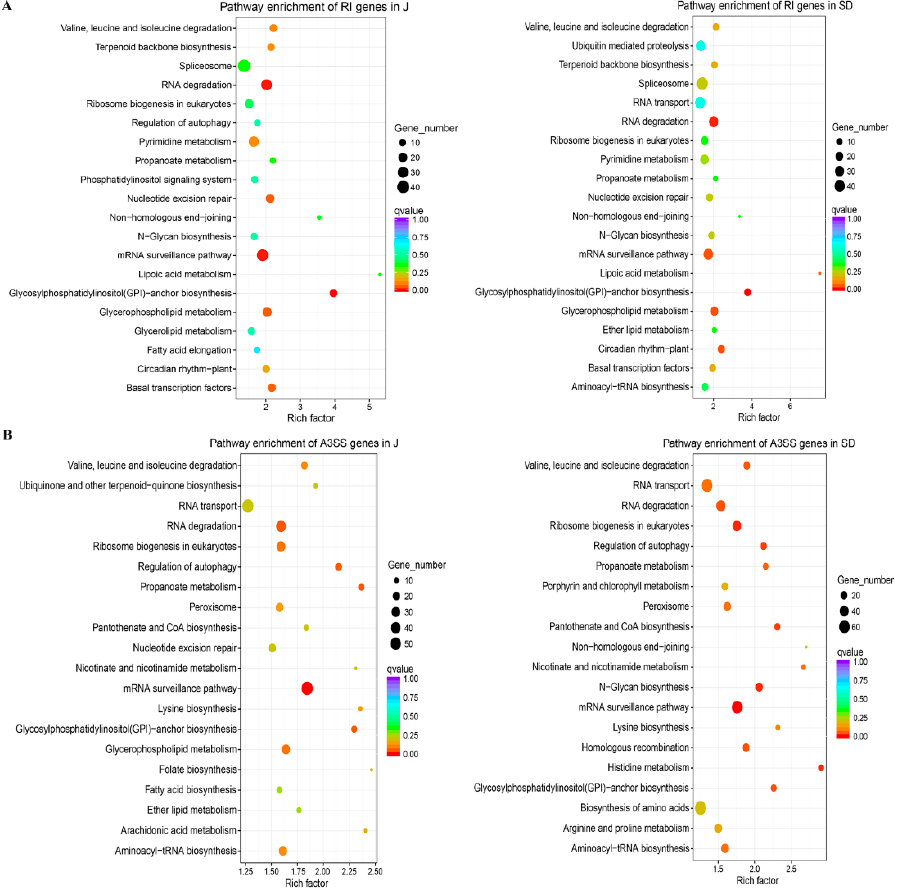
Figure 3. Comparative analysis of enriched KEGG pathways of RI and A3SS genes between J and SD in response to A. alternata AP infection. ( A ) Pathway enrichment of RI genes of J and SD in response to A. alternata AP infection. ( B ) Pathway enrichment of A3SS genes of J and SD in response to A. alternata AP infection. J: overlapped J36 and J72 groups; SD: overlapped SD36 and SD72 groups. The adjusted- p values are given with the color bar. The rich factor is noted at the x-axis and gene numbers are indicated by bubble scale.